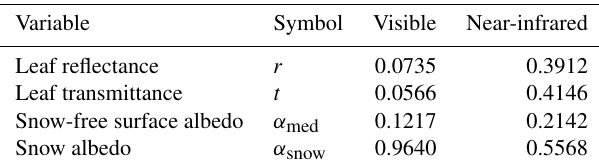
Table 2. Variables describing the optical properties of the leaves and the surface in the visible and near-infrared in the RAMI4PILPS cases (see Widlowski et al.,